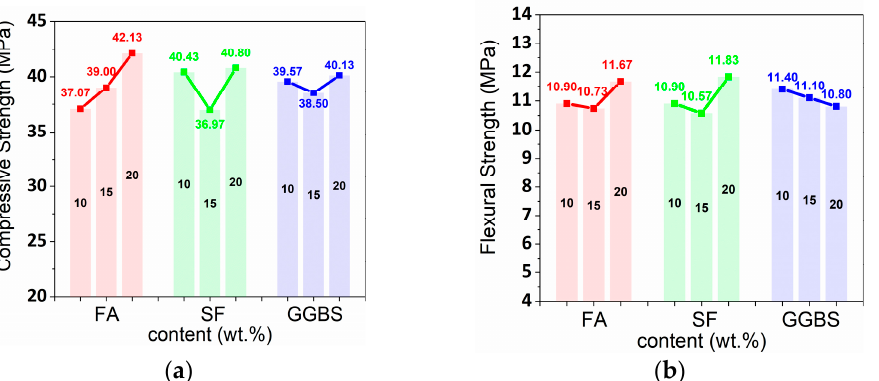
Figure 13. The compressive strength ( a ) and flexural strength ( b ) average values with the various content (10%, 15%, and 20%) of FA, SF, and GGBS, respectively.